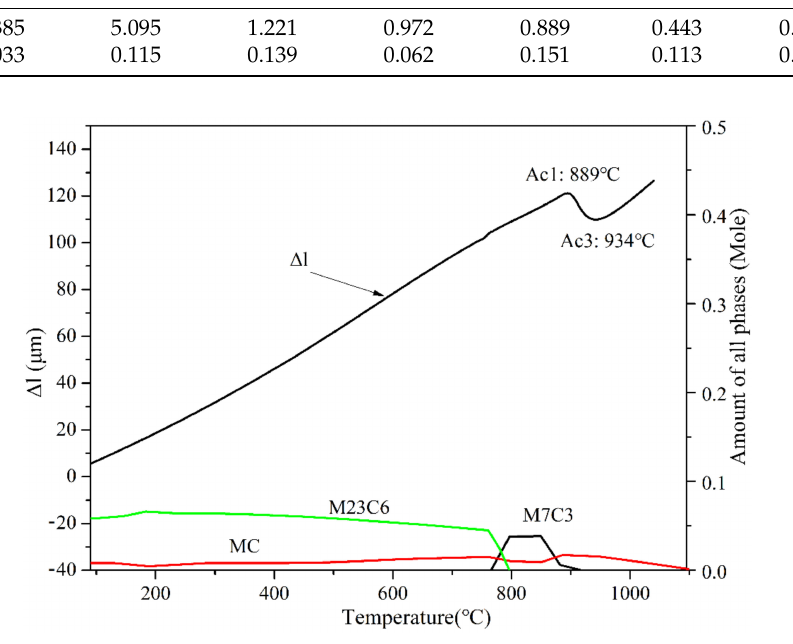
Figure 1. The expansion curve of H13 steel and the equilibrium precipitation curve of the